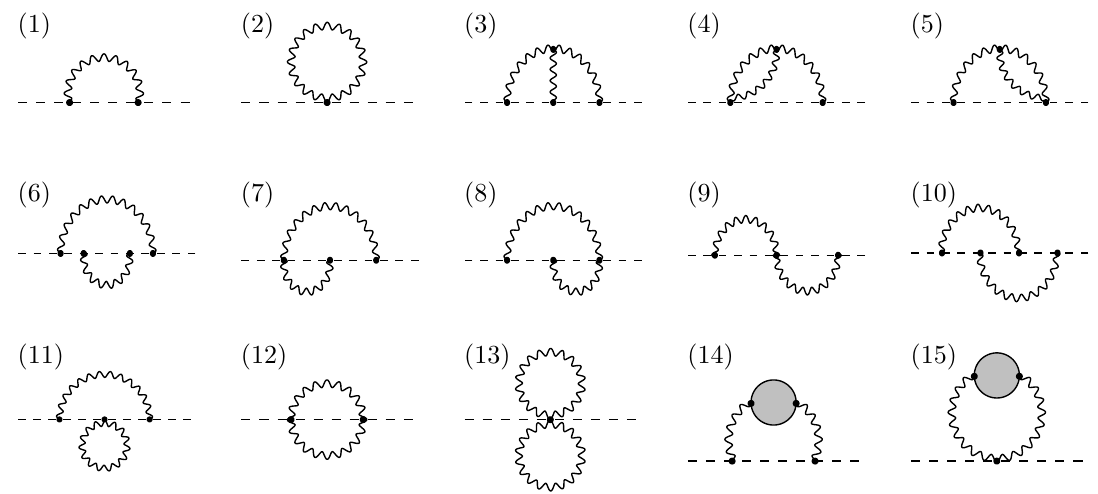
Figure 1 . One- and two-loop superdiagrams contributing to the two-point Green function of the Faddeev-Popov